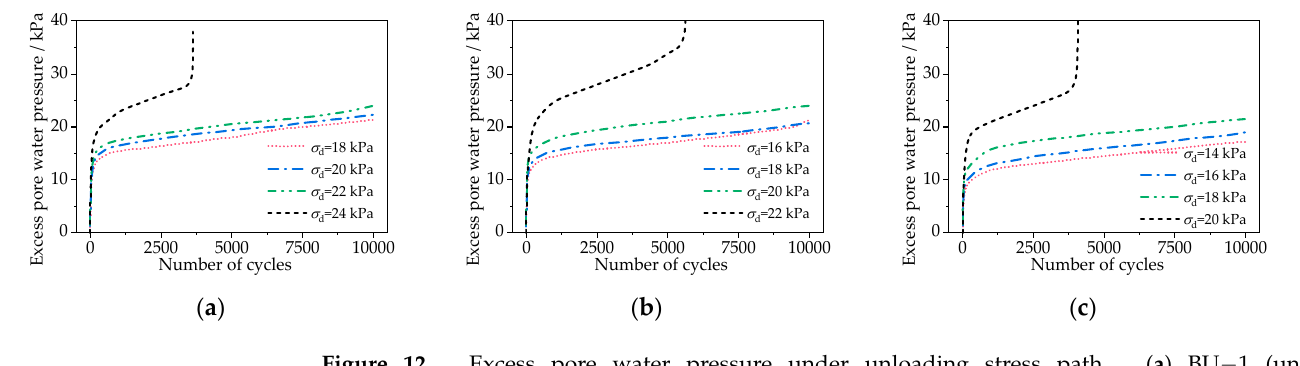
Figure 12. Excess pore water pressure under unloading stress path. ( a ) BU − 1 (unloading intensity = 10 kPa); ( b ) BU − 2 (unloading intensity = 20 kPa); ( c ) BU − 3 (unloading intensity = 40 kPa).